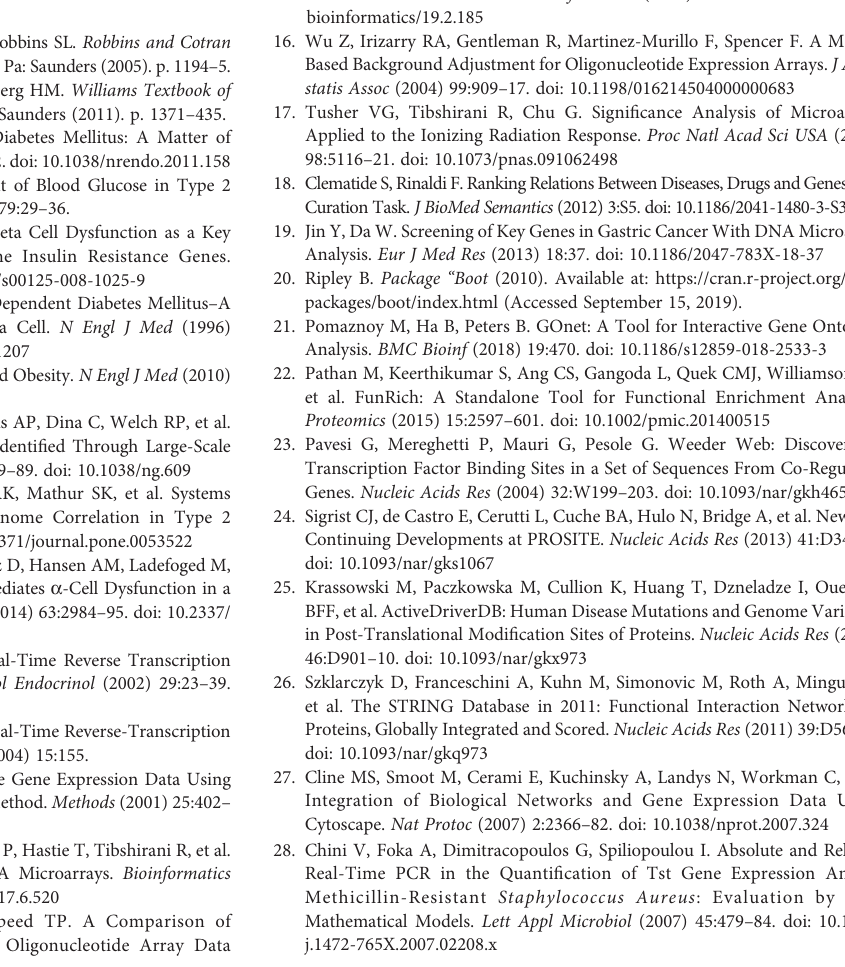
Supplementary Table 1 | List of cDNA datasets analyzed in this